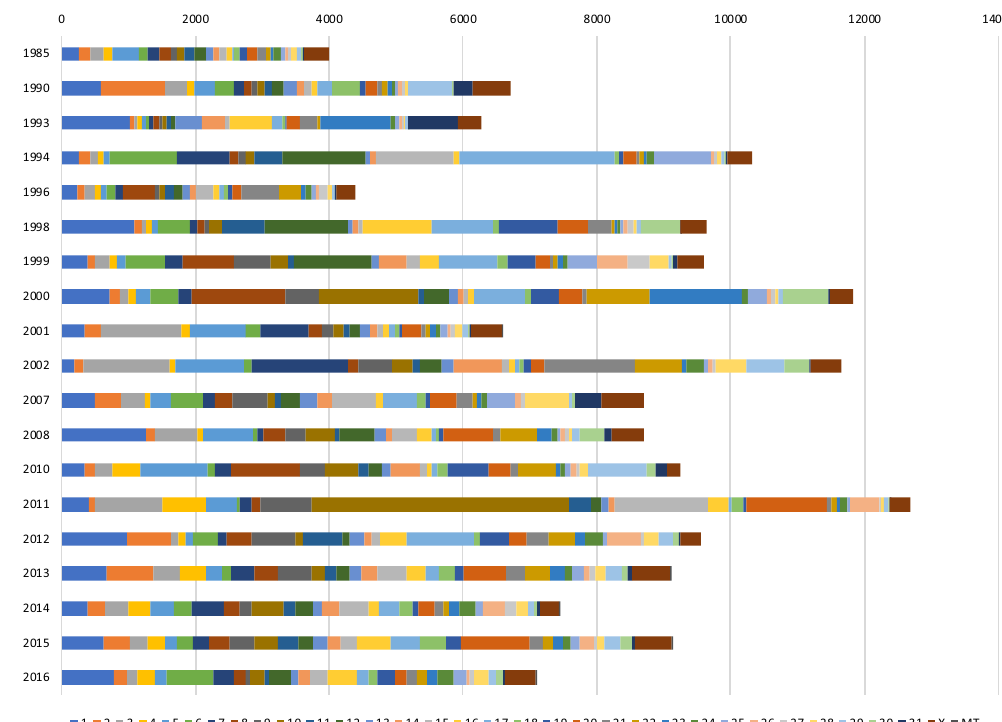
Figure 4. Mean number of rare variants detected from each horse grouped by birth-year. The number of horses born each year is shown in parentheses: 1985 (1 horse), 1990 (1), 1993 (1), 1994 (1), 1996 (1), 1998 (1), 1999 (3), 2000 (1), 2001 (1), 2002 (1), 2007 (5), 2008 (2), 2010 (2), 2011 (1), 2012 (4), 2013 (18), 2014 (20), 2015 (21), and 2016 (16). Colours represent different variant numbers on individual chromosomes.